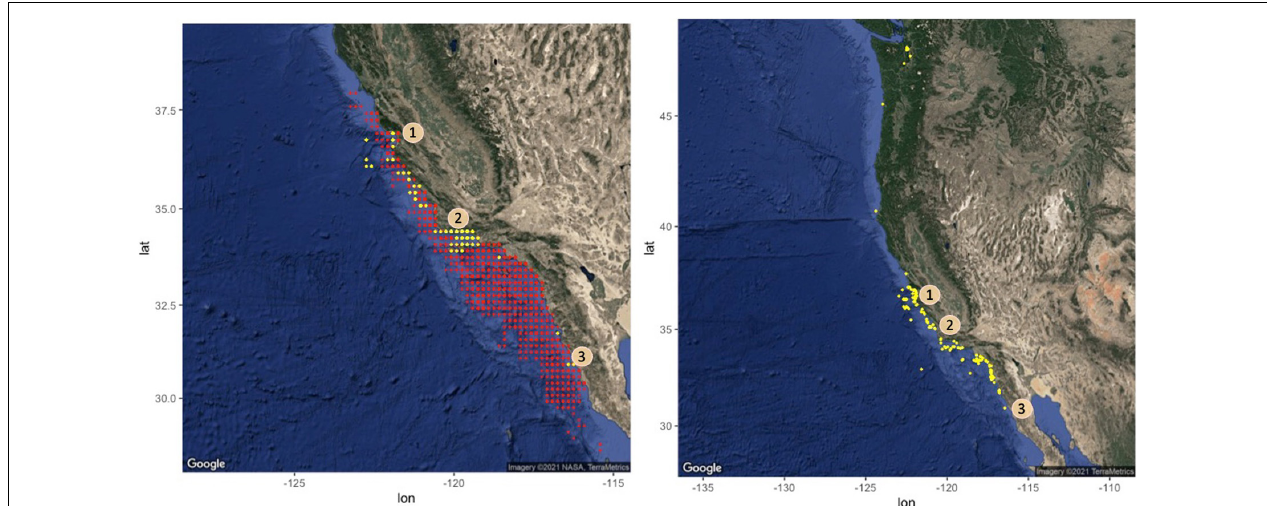
FIGURE 1 | Maps of sightings data collected from 1962 to 2018, from systematic surveys ( left ; 1962–1997) and non-systematic data ( right ; 1973–2018) along the western coast of the United States and Mexico. Presences are denoted in yellow. Those above 46 ◦ latitude were observed in the bay near Seattle, WA (United States). Sightings from drift gillnet records have been excluded in this figure because of NOAA confidentiality policies. Centroids of blocks where sharks were not found, based on systematic surveys by pilots who had reported a basking shark at least once, are marked in red. Numbers indicate shark hotspots identified in both this and previous studies, in (1) Monterey Bay, (2) Santa Barbara, and (3) Baja